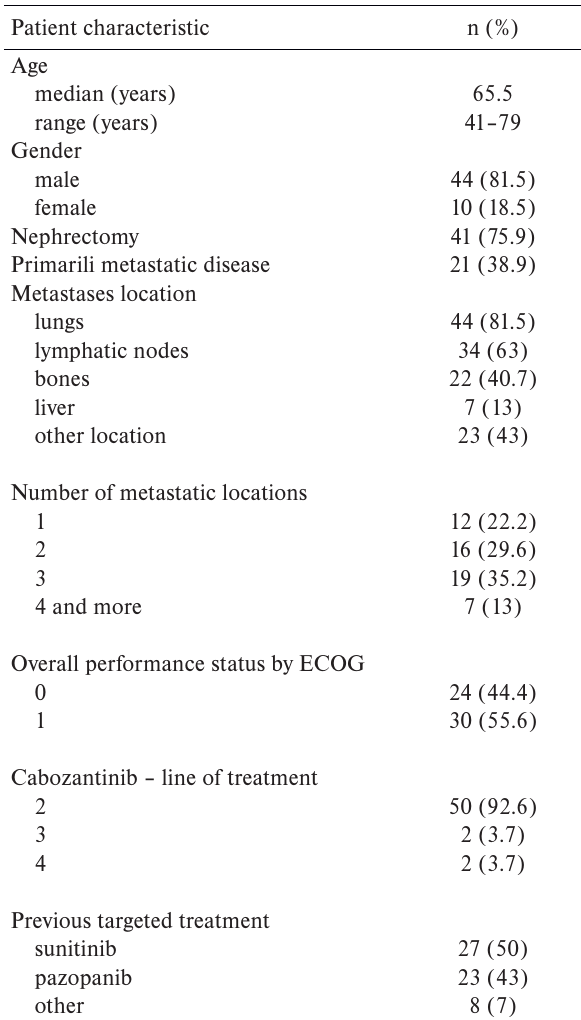
Table 1. Patients